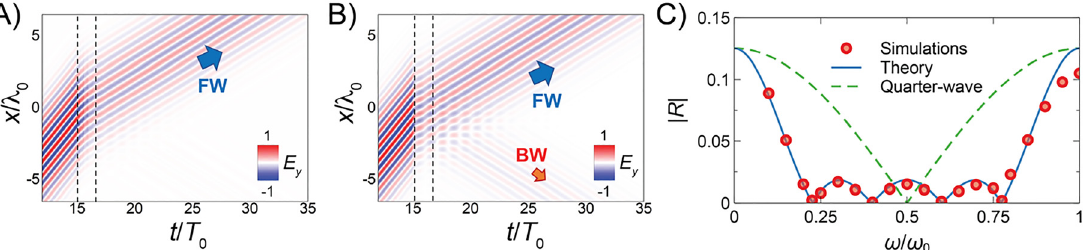
Figure 5: Chebyshev design: n i = 1, n e = 2, M = 4, n 1 = 1 . 120, n 2 = 1 . 298, n 3 = 1 . 541, n 4 = 1 . 786. δ 1 = 0 . 280 T 0 , δ 2 = 0 . 324 T 0 , δ 3 = 0 . 385 T 0 , and δ 4 = 0 . 446 T 0 . (A), (B) Numerically computed space-time maps (normalized electric field) for narrowband modulated Gaussian pulses with center angular frequency ω 0 and 0 . 2 ω 0 , respectively. The vertical dashed lines indicate the initial ( t 0 = 15 T 0 ) and fi nal ( t M = 16 . 436 T 0 ) temporal boundaries. (C) Comparisonbetween numerically computed (red circles) and theoretical (blue-solid curve) BW wave coef fi cient magnitudeas a function of normalized angular frequency (in the fi nal medium). Also shown (green-dashed curve), as a reference, is the response of the quarter-wave design ( M = 1, n 1 = 1 . 414, and δ 1 = 0 . 354 T 0